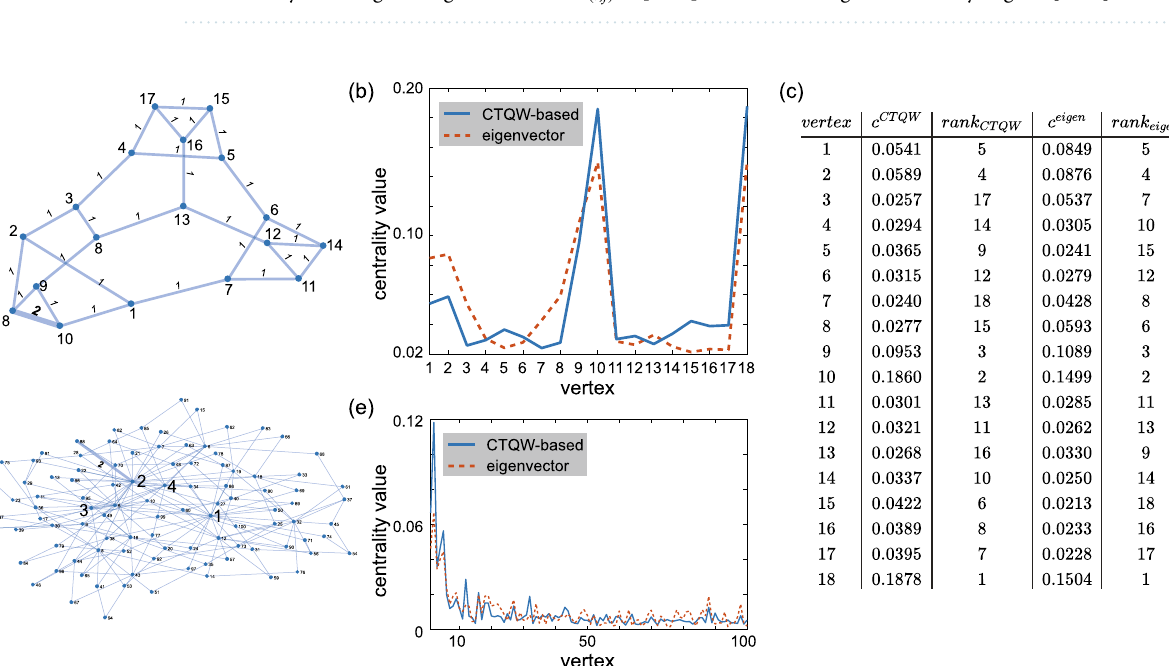
Table 1. The average correlation coefficients for graphs with different topologies. The superscript w denotes only one weighed edge w